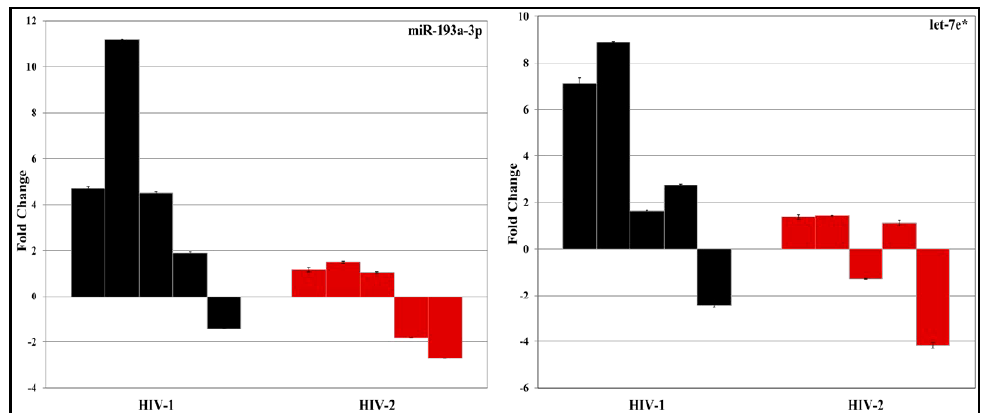
Figure 4. PBMC isolated from independent donors were stimulated and infected with known amounts (5 ng/mL p24/p27 units per 10 6 cells) of HIV ‐ 1 (MN) and HIV ‐ 2 (ROD) viruses. Two hours post ‐ infection, the tubes were washed with PBS to remove un ‐ adsorbed virus and cells cultured in complete RPMI ‐ 1640 media. Culture supernatants and cells were harvested day 7 post infection. The expression of selected miRNAs was tested in all the independent donor samples using Real ‐ time PCR (RT ‐ PCR). The two ‐ step RT ‐ PCR method was used with TaqMan MicroRNA Reverse Transcription Kit and TaqMan miRNA specific primers (Life Technologies, Inc., Waltham, MA, USA) according to manufacturer’s protocols. RNU44 was used as an internal control for normalization between each donor. Each sample was run in triplicate to ensure accurate fold change estimation. Relative miRNA expression was calculated by the 2^ [ − { Δ Ct (infected) − Δ Ct (uninfected)}] formula. Results are expressed as mean ± standard error of the mean (SEM) of all independent donors’ experiments.